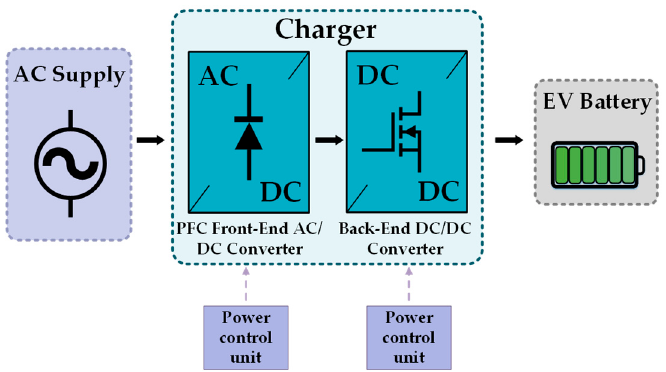
Figure 2. Block diagram of a conductive unidirectional EV charging system.